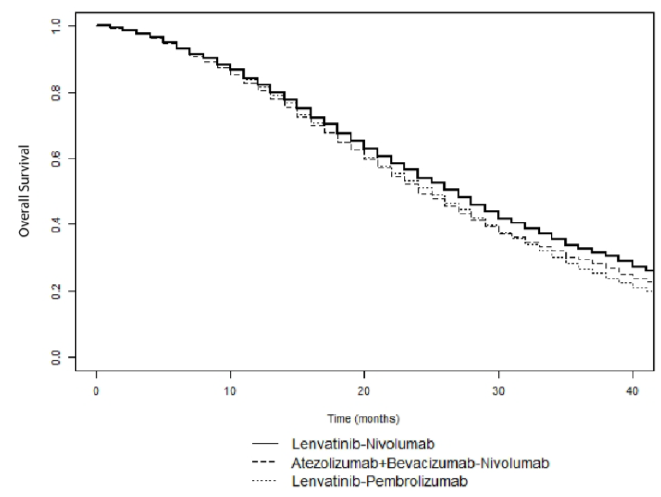
Figure 2. Simulated survival curves of Lenvatinib followed by Nivolumab, Lenvatinib followed by Pembrolizumab, and Atezolizumab plus Bevacizumab followed by Nivolumab sequences in patients with advanced HCC.